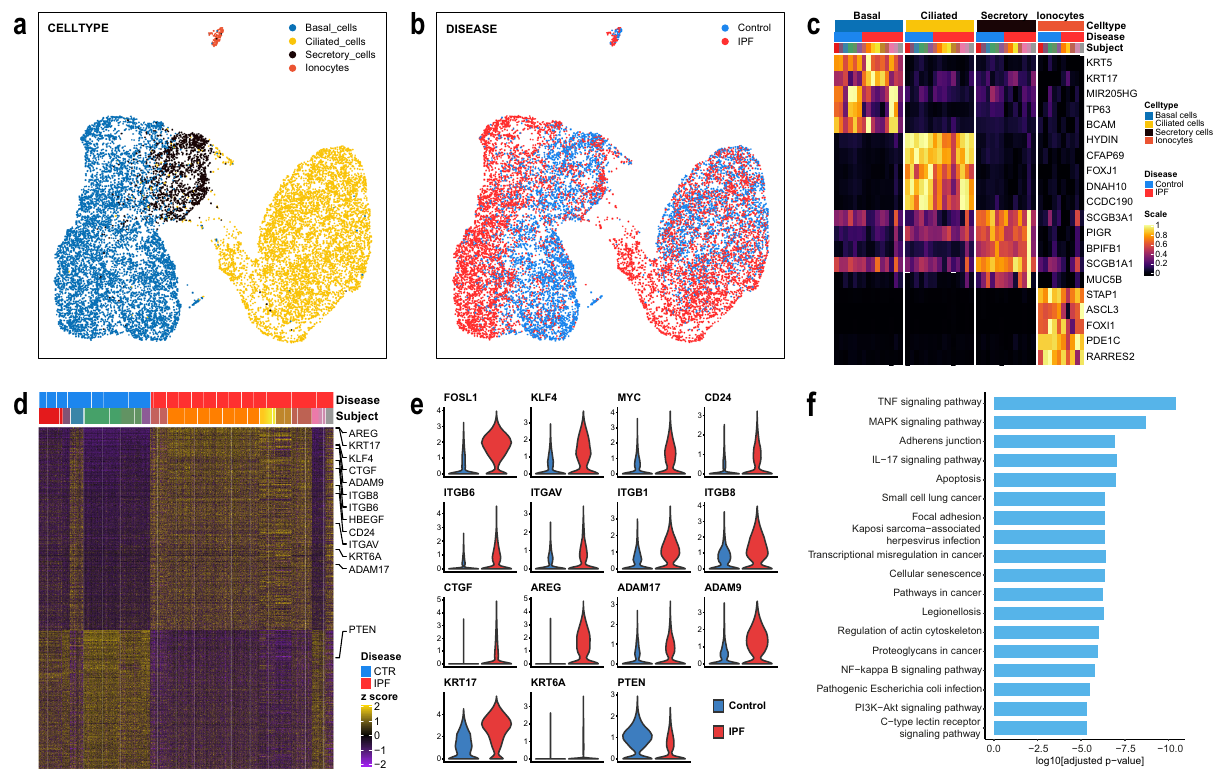
Fig.1|Single-cellRNAseqofbronchialepithelialcells. scRNAseqwasperformed on brush cells of IPF patients ( n =9) and nonUIP ILD controls ( n =6). a , b Uniform Manifold Approximation and Projection (UMAP) of n =14,873 single-cell tran- scriptomesvisualizesthefourmajordiscrete epithelialcelltypes(detected UMAPs colored by a cell types, b disease state). c Heatmap of unity normalized canonical epithelial marker gene expression, averaged per subject, grouped by cell type, as